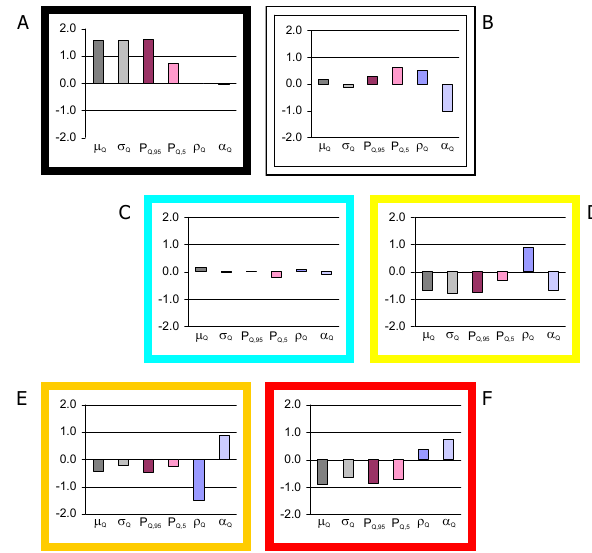
Fig. 3. Topology map of 6-cluster (3 × 2) SOM classification of streamflow signature